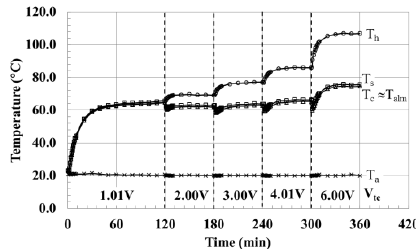
Figure 6. Transient temperatures for the FHS-TE assembly (NC (Natural convection), P EH = 10 W, Run D1).